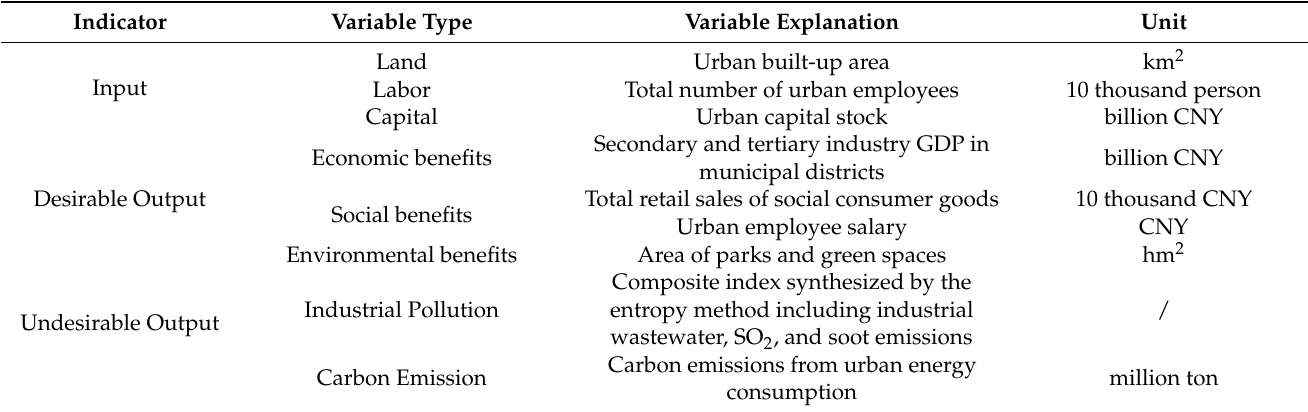
Table 1. Input-output index table of Super-SBM